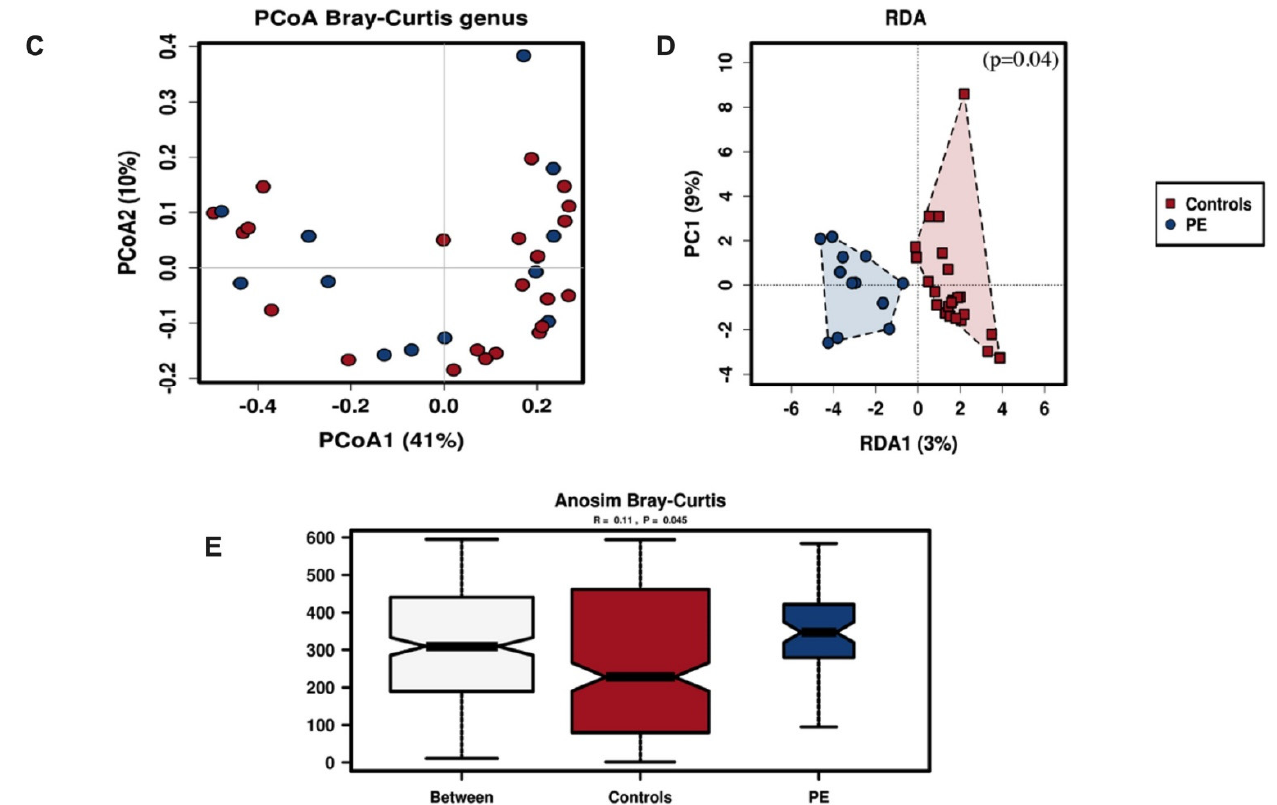
Figure 1. Oral microbiota diversity. Alpha diversity for oral samples of pregnant women with preeclampsia (DPE) ( n = 12) compared to control ( n = 24) group at 36 weeks pregnancy using Shannon ( A ) and Chao-1 ( B ) indices. Beta diversity was assessed with PCoA ( C ), RDA ( D ) and Anosim ( E ) analysis. Red symbols signify the women in the control group and blue symbols the women who developed preeclampsia.